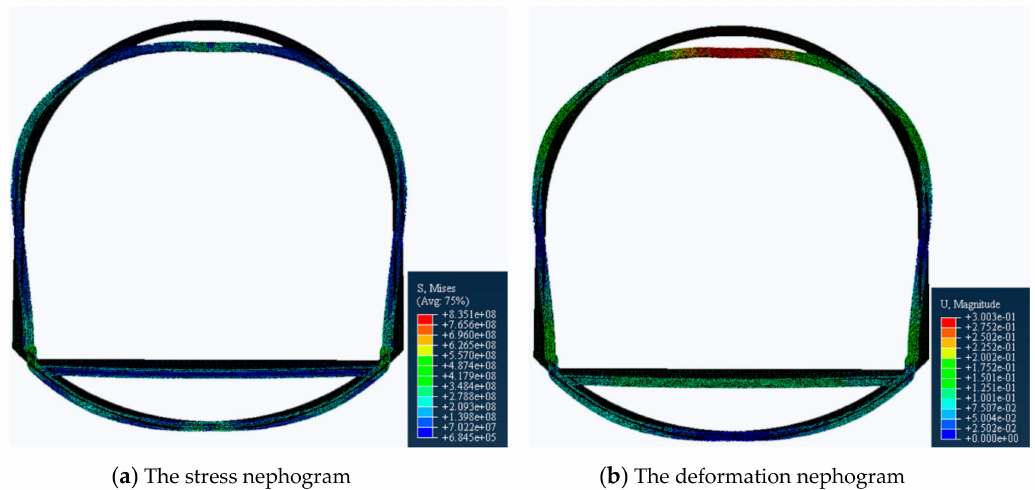
Figure 16. The stress nephogram and the deformation nephogram of FB set III.